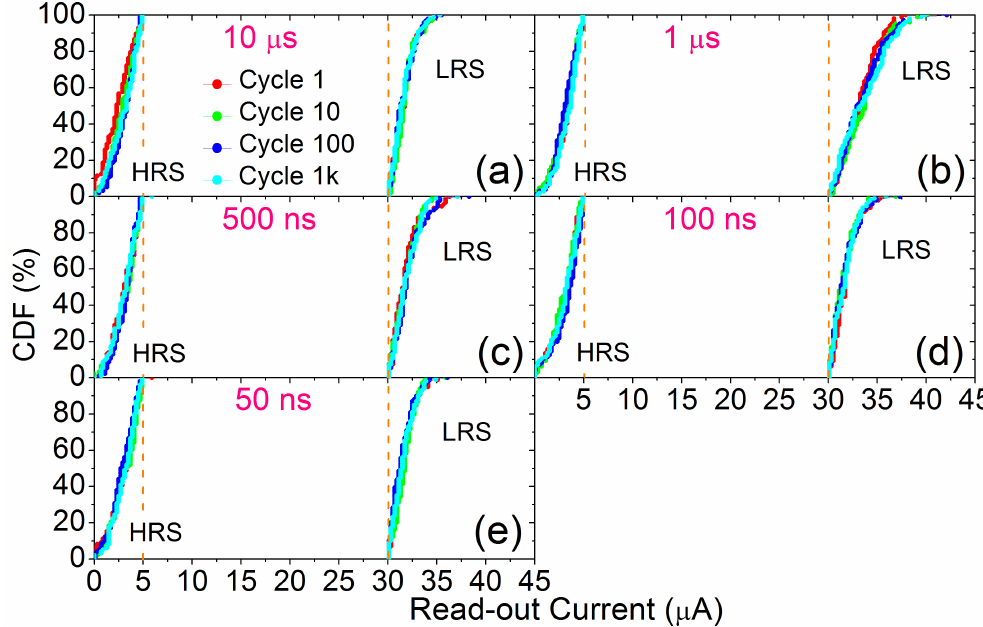
Figure 7. CDFs of read-out currents measured just after the reset (HRS) and set (LRS) transitions during 1k endurance cycles (logarithmically sampled: 1, 10, 100 and 1k cycles) for every programming pulse width: 10 µ s ( a ), 1 µ s ( b ), 500 ns ( c ), 100 ns ( d ) and 50 ns ( e